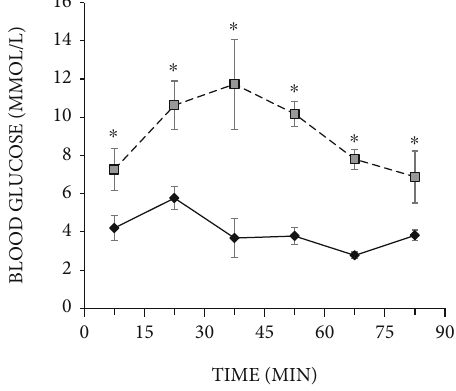
Figure 3: Intraperitoneal insulin tolerance test on control rats ( n = 12 , solid line) and rats with T2DM ( n = 12 , dashed line) before administration of substances. Blood samples were collected from the tail at the indicated time points and analyzed for glucose concentration (mmol/l). Values are means ± SEM . ∗ p < 0 : 05 compared with